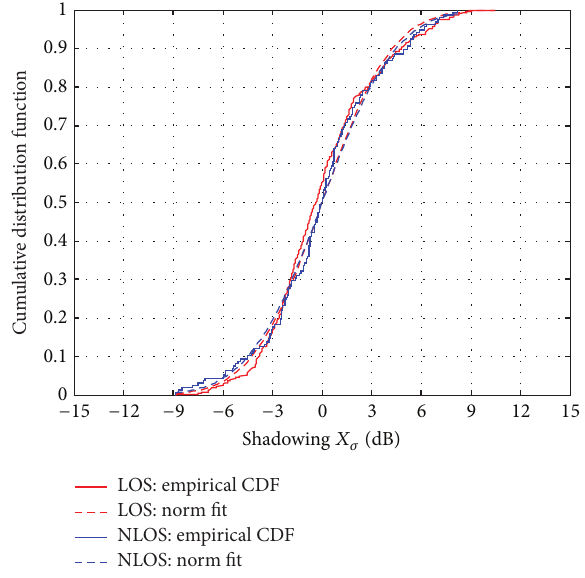
Figure 4: CDFs of the shadowing of the proposed model (LOS and NLOS